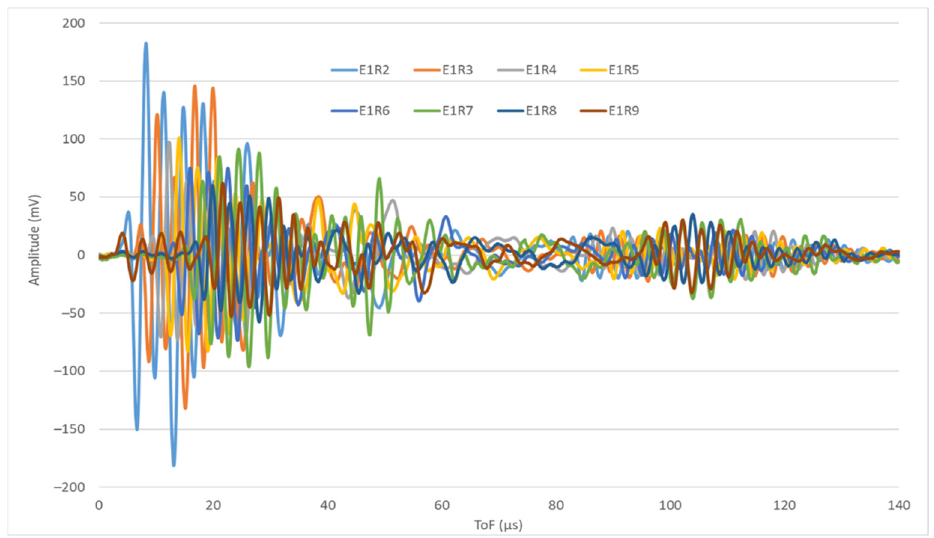
Figure 4. Signals E1R2-E1R9, i.e., signals emitted by PWAS 1 and received by PWAS 2 to PWAS 9.